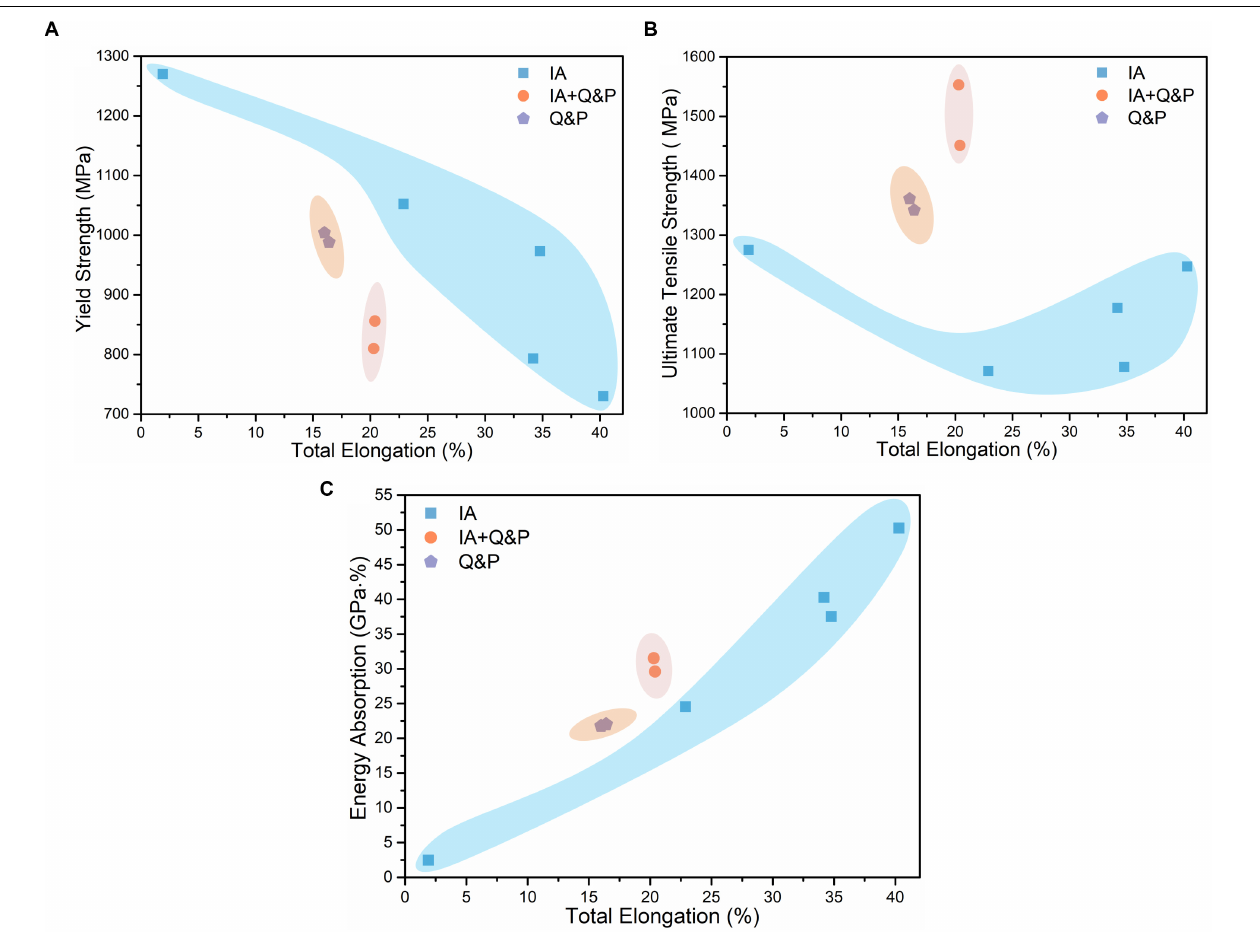
steels is higher than that of the Q&P steels. So the austenite of